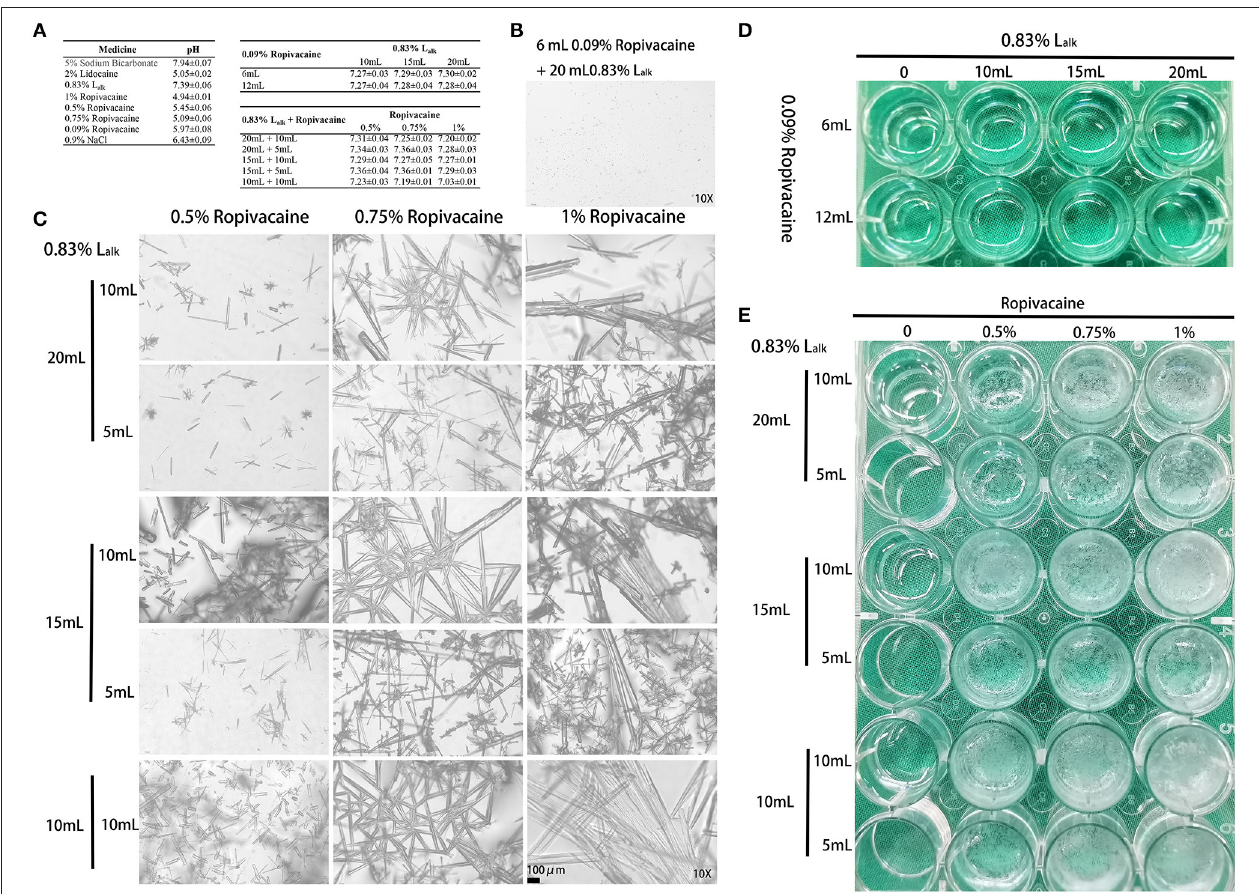
FIGURE 1 | Crystallization of medicine. (A) The pH values of each medicine (mean ± SEM) detected by Sartorius PB-10 within 10min ( n = 3–6). (B) Microscopic image (10X) of the 6mL 0.09% ropivacaine + 20mL 0.83% L alk group after mixing over 1h. (C) Microscopic image (10X) of the 0.83% L alk – ropivacaine (0.5–1.0%) mixture. (D) Macroscopic appearance of the 0.09% ropivacaine (routine labor analgesia) – 0.83% L alk (routine doses). (E) Macroscopic appearance of the 0.83% L alk – ropivacaine (0.5–1.0%) mixture. L alk , alkalized